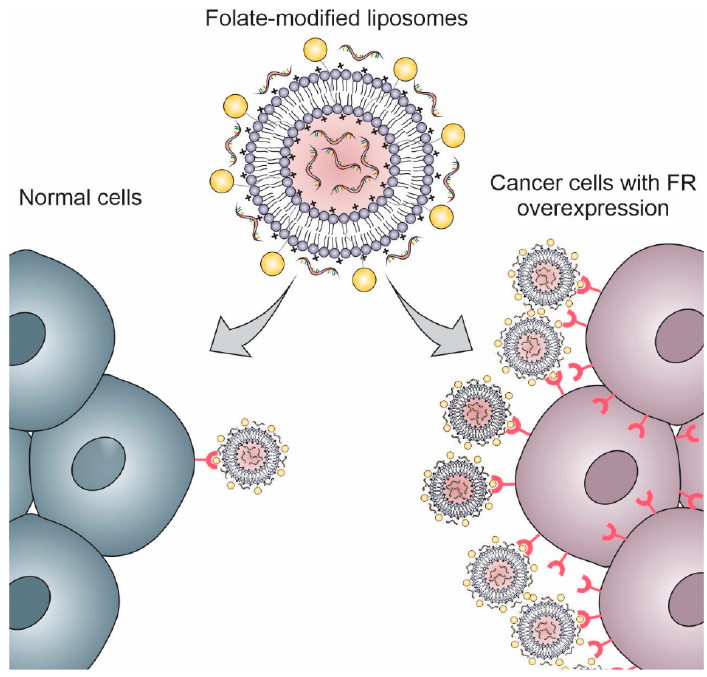
Figure 6. Schematic representation of folate receptors (FR) overexpression in cancer cells compared with normal cells.